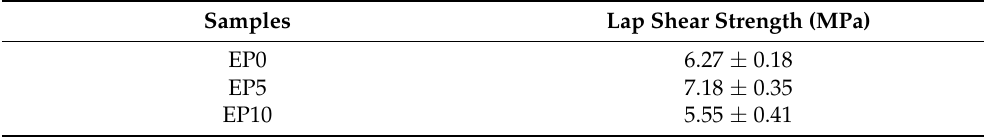
Table 4. Single lap shear test results for EP